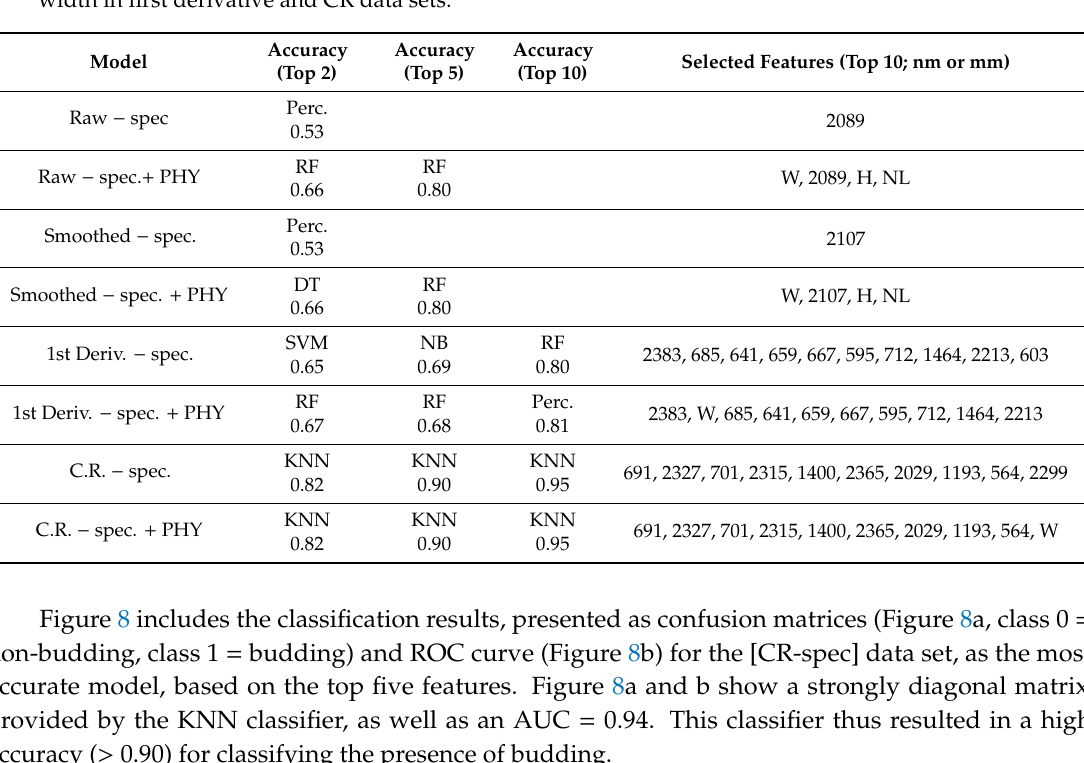
Table 4. Results for growth stage classification—snap bean budding. Note the detection of canopy width in first derivative and CR data sets.